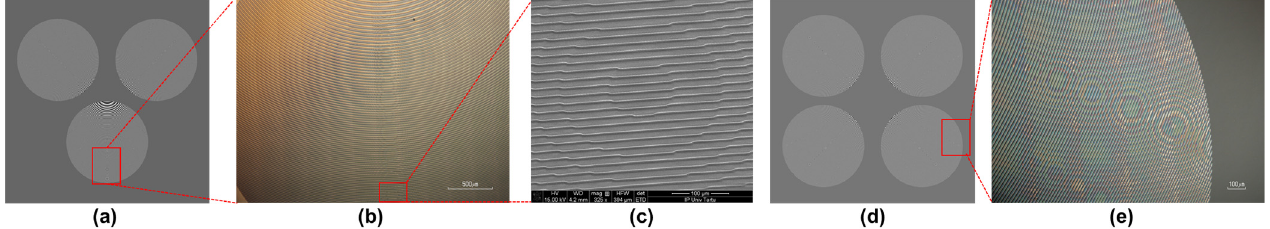
Figure 8. ( a ) Image of the design of LADISA with three apertures, ( b ) optical microscopy image and ( c ) SEM image of a section of one of the sub-apertures of LADISA. ( d ) Image of the design of LADISA with four apertures and ( e ) optical microscopy image of a section of one of the sub-apertures of